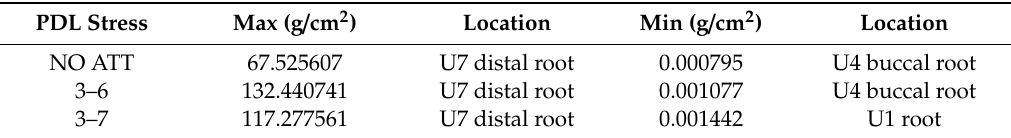
Table 4. Periodontal ligament (PDL)